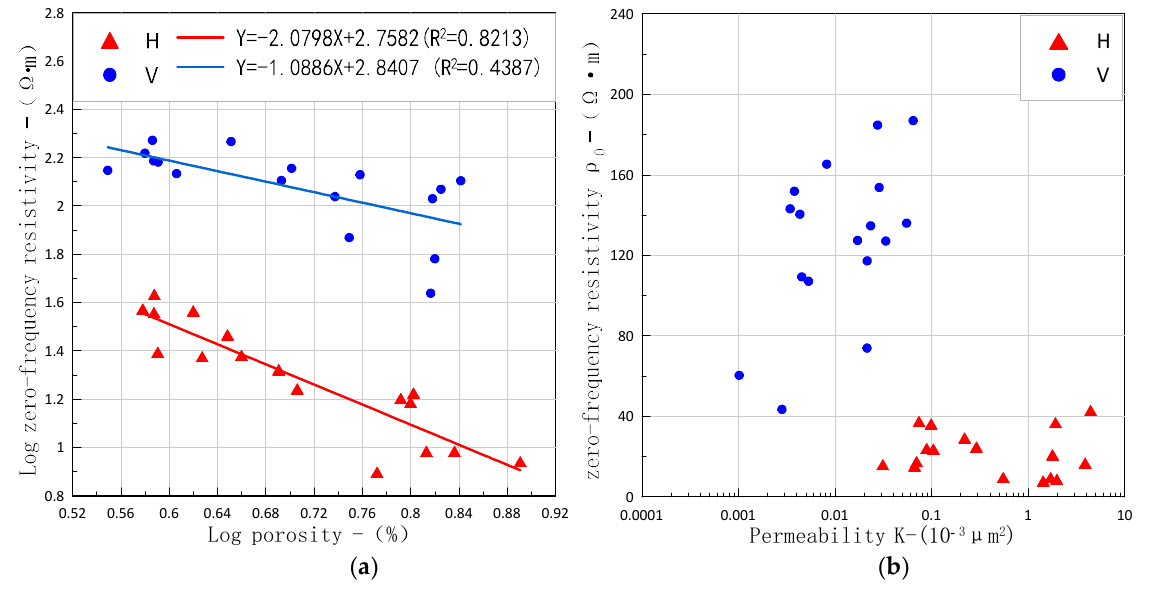
Figure 9. Intersection diagram of zero-frequency resistivity, porosity and permeability at normal temperature and pressure. ( a ) Zero-frequency resistivity and porosity; ( b ) zero-frequency resistivity and permeability.